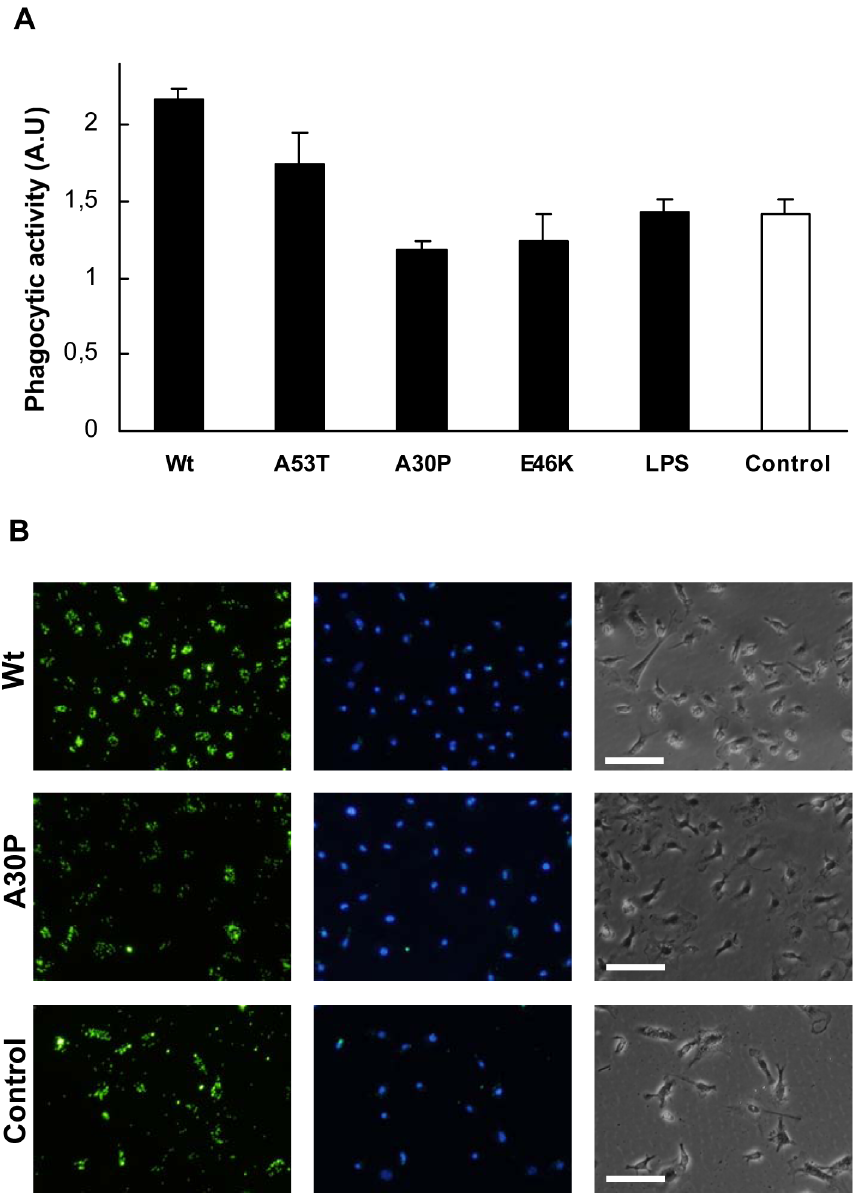
Figure 6. Effect of a -Syn-stimulation on microglial phagocytosis. ( A ) After treatment of the primary microglial cell cultures with a -Syn (1 m g/ ml) for 20 hours, cells were incubated with fluorescent microspheres for 1 hour. After fixing the cells, phagocytosis was assessed by fluorescence microscopy analysis. The phagocytic index was calculated by dividing the fluorescence from the phagocytosed microspheres by the total number of cells in the images. Four images were analysed for each sample in each experiment, and the results shown are representative of three independent experiments. A.U.: arbitrary units. (Representative microscopy images used to determine the phagocityc activity of microglial cultures stimulated with Wt (top) an A30P (centre) a -Syn, or non stimulated microglial cells (bottom). From left to right, green fluorescent microspheres, Hoechst-stained cells, and cells as observed in the absence of fluorescence. Scale bar: 50 m M.